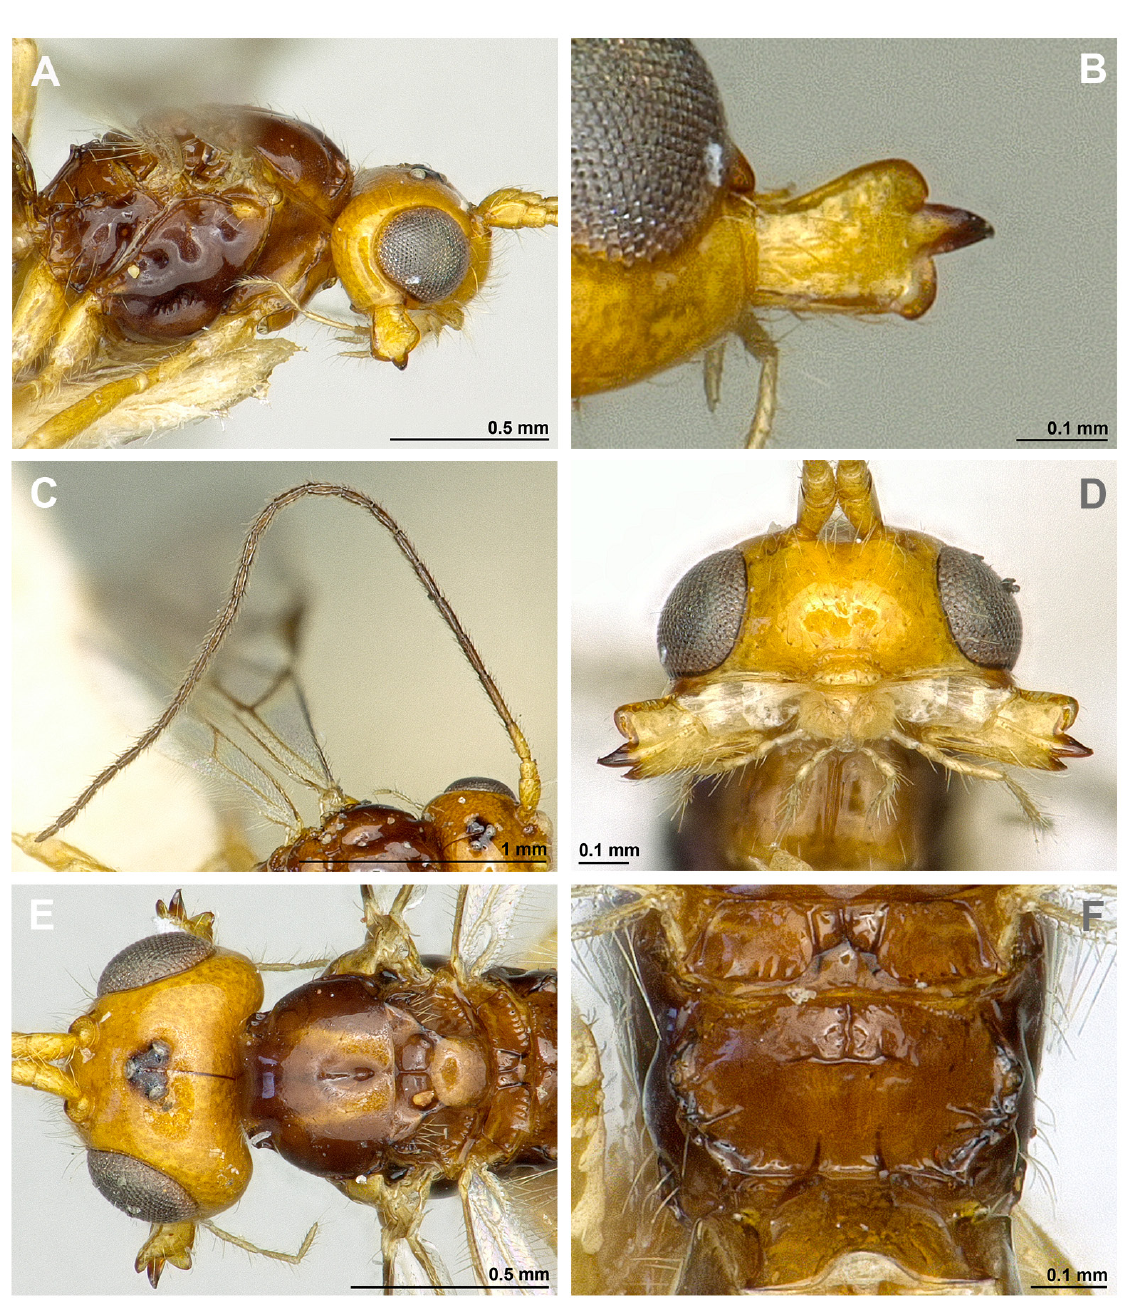
Fig. 27. Asobara kawandensis Peris-Felipo, sp. nov., ♀, holotype (BMNH). A . Head and mesosoma, lateral view. B . Mandible. C . Antenna. D . Head, front view. E . Head and mesoscutum, dorsal view. F .